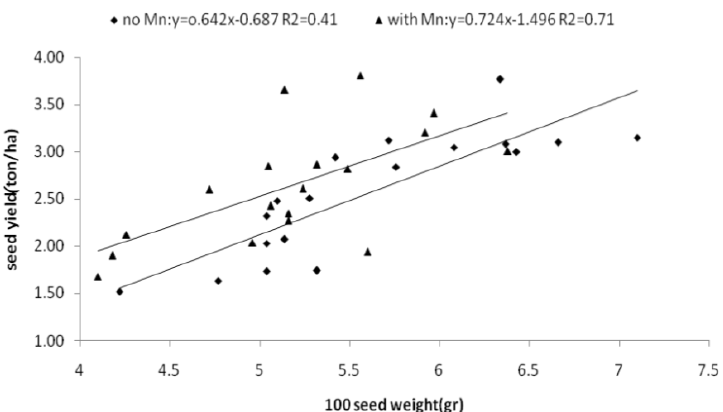
Fig. 3. Relationship between seed yield and 100 seed weight in case of Mn (with Mn) and without Mn (no Mn) application in